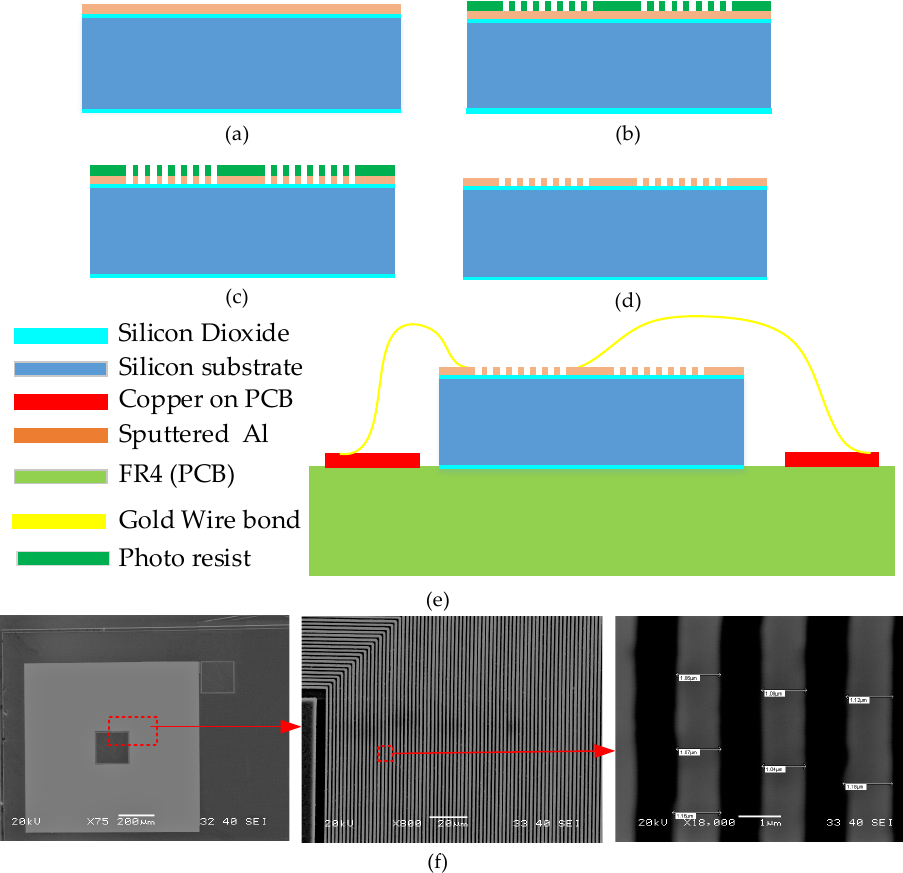
Figure 7. Fabrication processes of single-layer µSCM using a silicon wafer. ( a ) Thermal oxidation and Al sputtering. ( b ) Photoresist patterning by contact photolithography. ( c ) Al dry etch. ( d ) Pho- toresist removal by dry method. ( e ) Wafer dicing and wire bonding. ( f ) SEM pictures of one of the fabricated µSCMs.